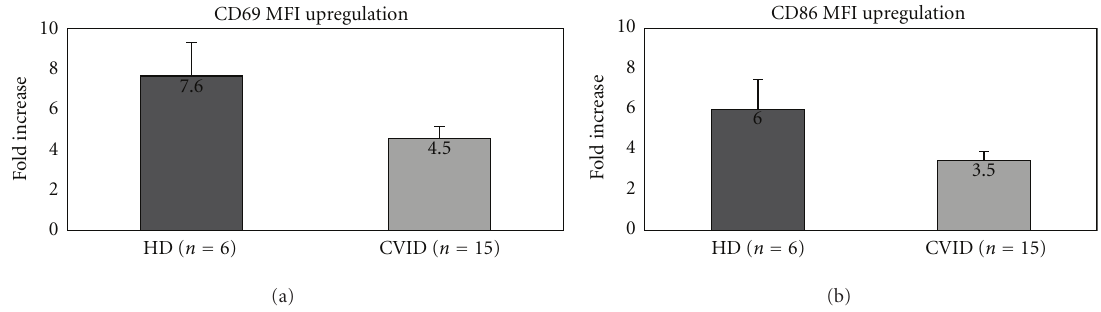
Figure 3: Defective upregulation of activation markers (CD69, CD86) after in vitro stimulation with CpG in CVID. (a) Fold increase in CD69 expression in healthy controls and CVID patients CVID (mean of six and fifteen samples, resp.). (b) Fold increase in CD86 expression in healthy controls and CVID patients (mean of six and fifteen samples, resp.). Graph bars show standard error (SE).